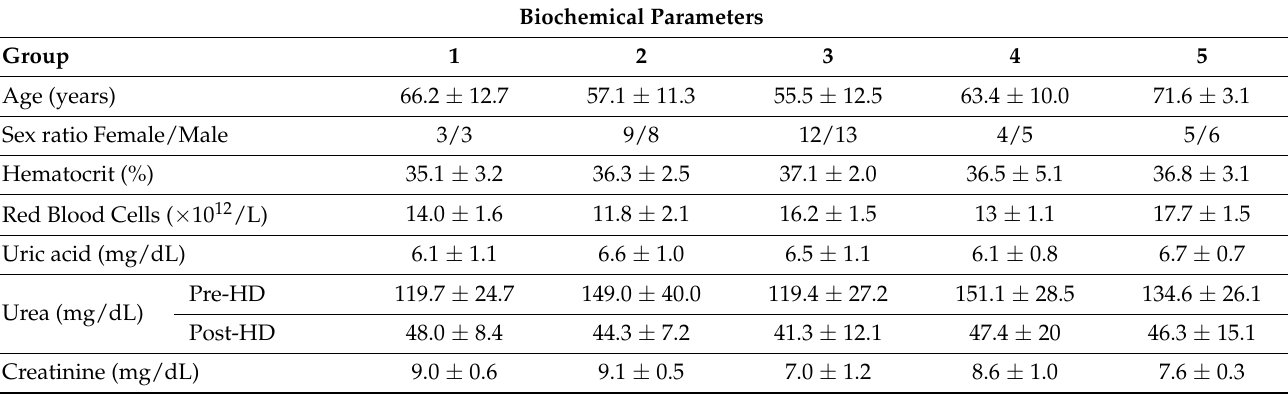
Table 1. Selected biochemical parameters of patients (mean ± standard deviation SD). Biochemical